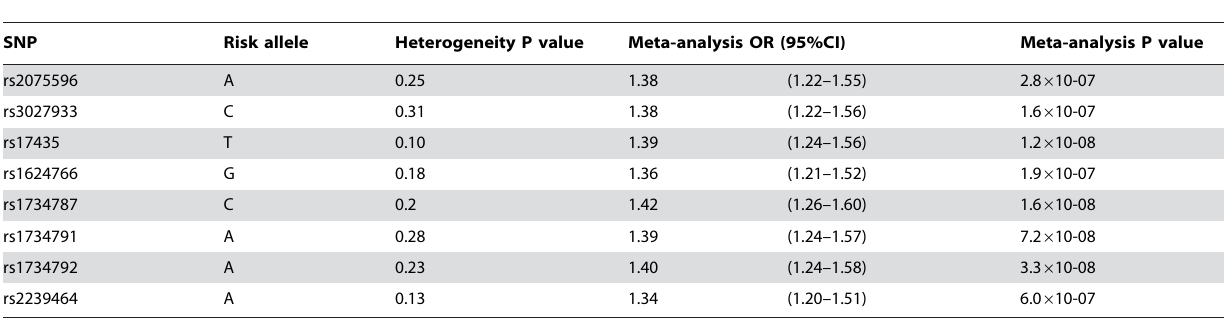
Table 7. Meta-analysis for risk alleles in SLE-associated MECP2 SNPs in Korean and European-derived cohorts